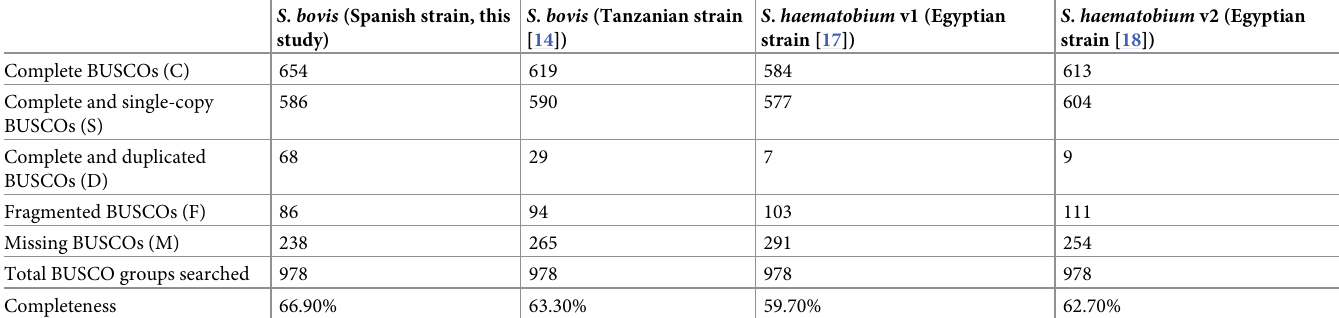
Table 3. Genome assembly and annotation completeness using BUSCO.